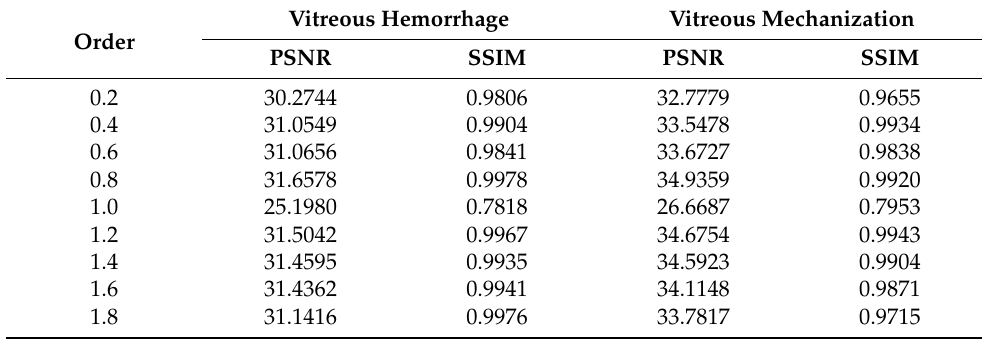
Table 1. Evaluation index of the image after denoising of different orders α . Order